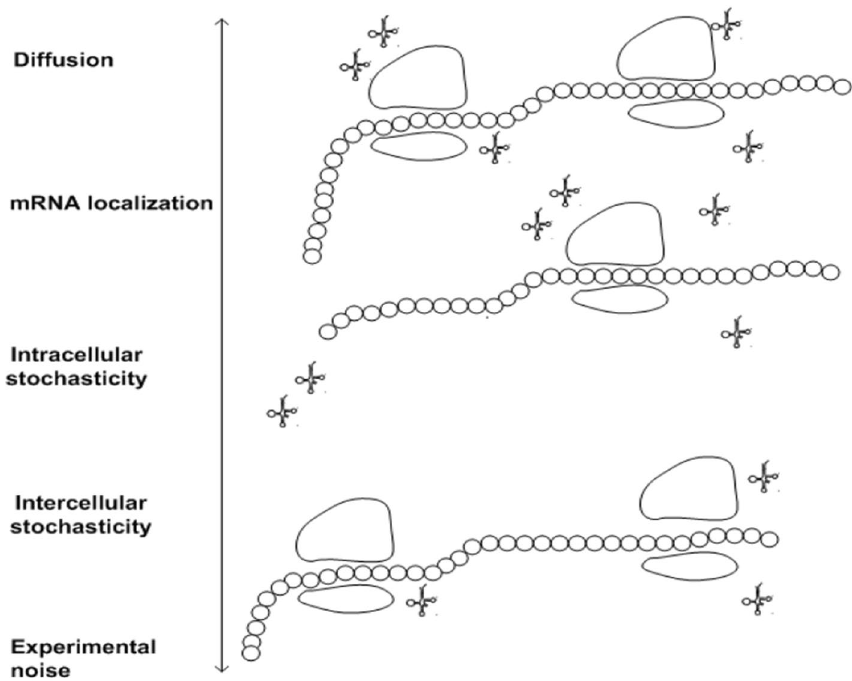
Figure 1. Stochasticity and noise in mRNA translation and its measurements imply that identical mRNAs chains may have different transition rates. The double arrows represent tRNA